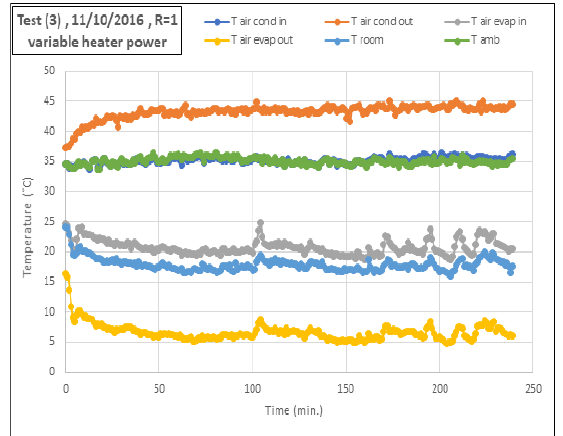
Fig. 9b. Refrigerant temperature with time for test2.